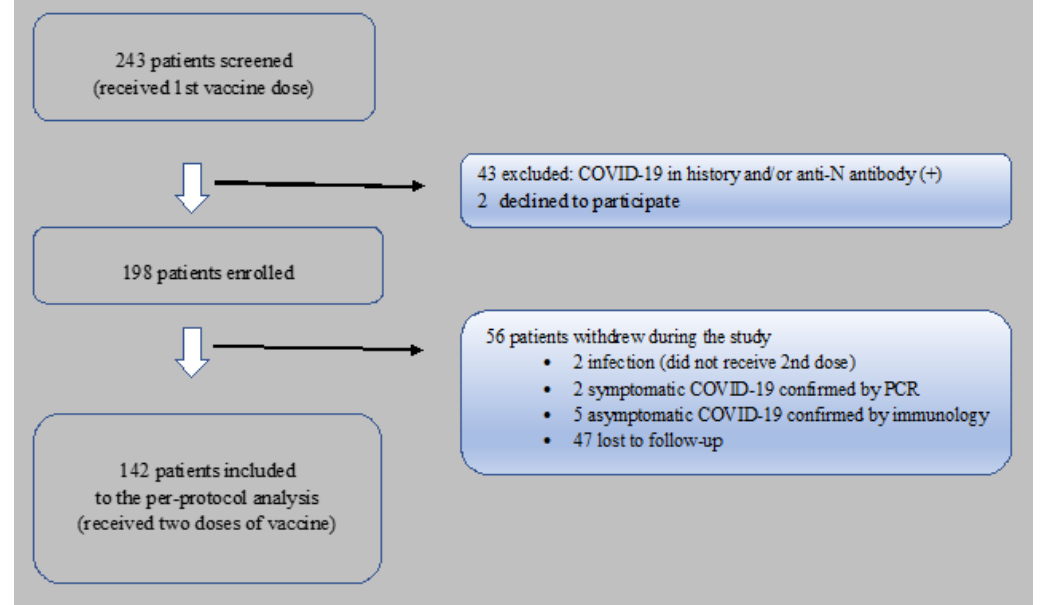
Figure 1. Flow chart of kidney transplant recipients vaccinated against COVID-19, screened and included to the per-protocol analysis. Table 1. Demographic and clinical characteristic study and control group.